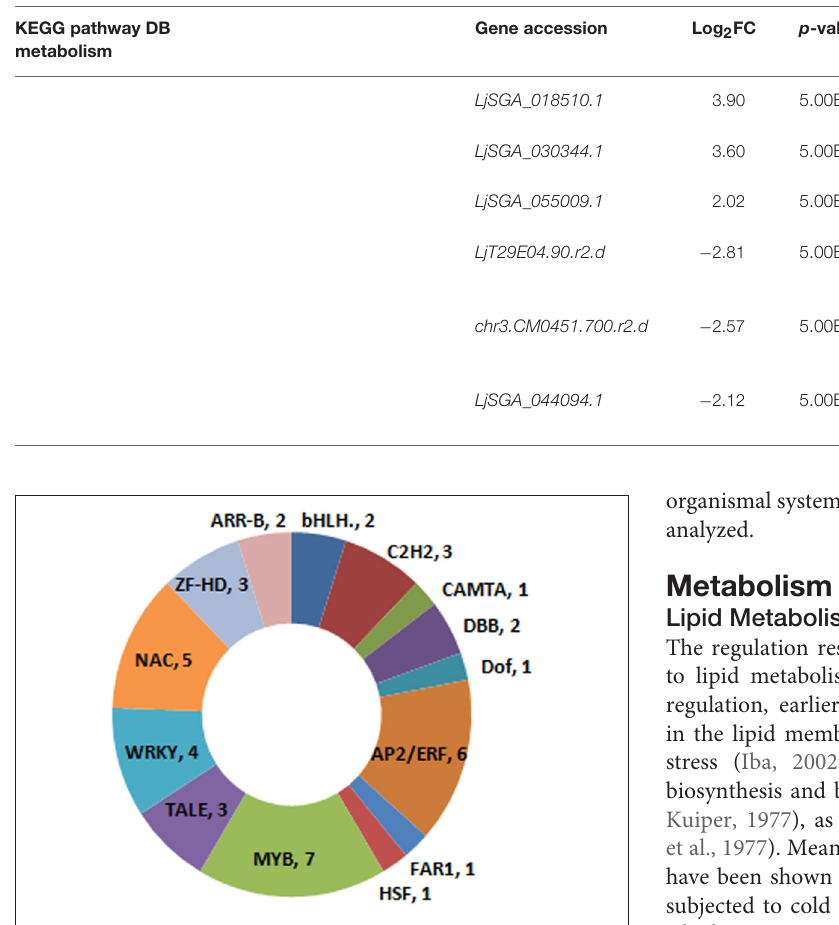
FIGURE 5 | Classification of cold stress up-regulated TFs.